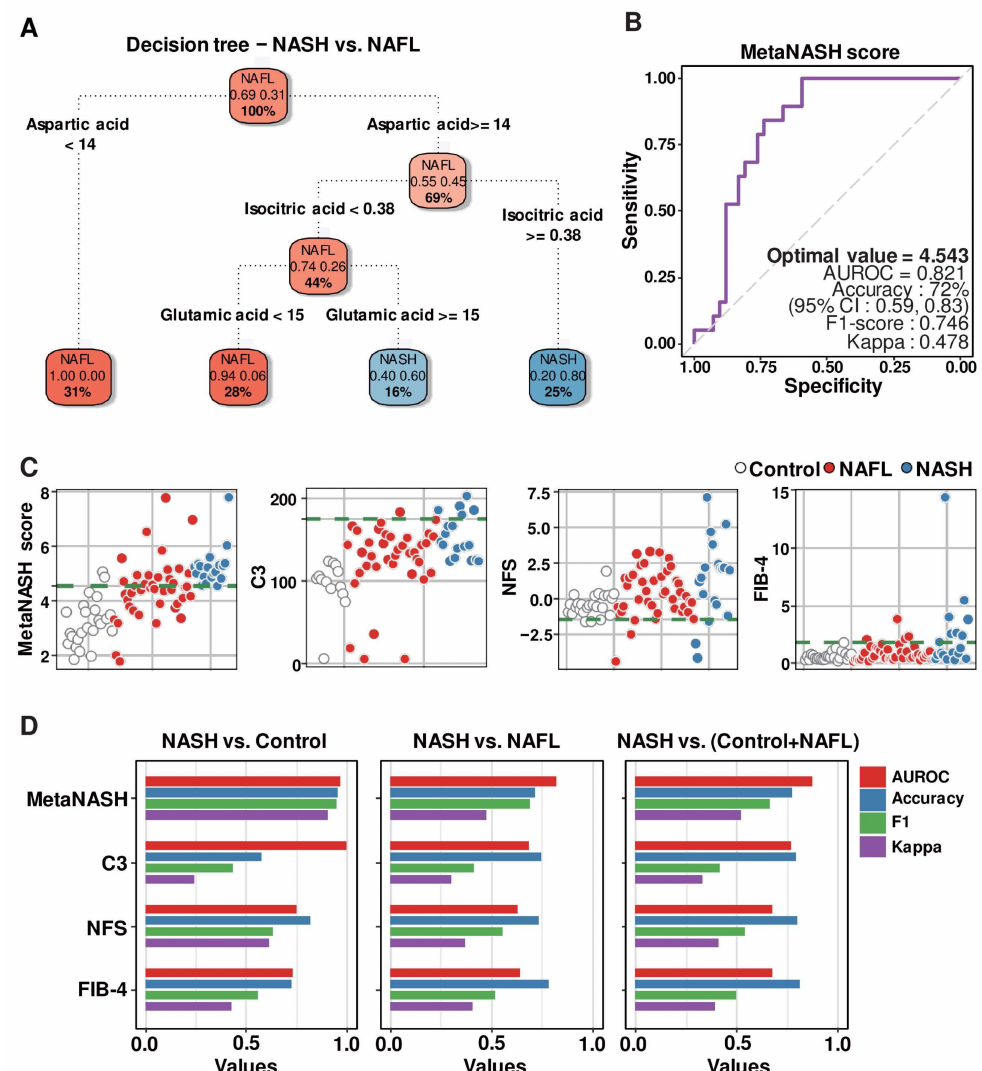
Figure 5. Development of the MetaNASH score as a diagnostic index for NASH. ( A ) Decision trees summarizing the process of ML-based selection of three essential features identifying patients with NASH. ( B ) AUROC curve highlighting the performance of the MetaNASH score. ( C , D ) Comparison of the predictive power of the MetaNASH score and other clinically applicable parameters. Scatter ( C ) and bar ( D ) plots comparing the predictive power of each diagnostic